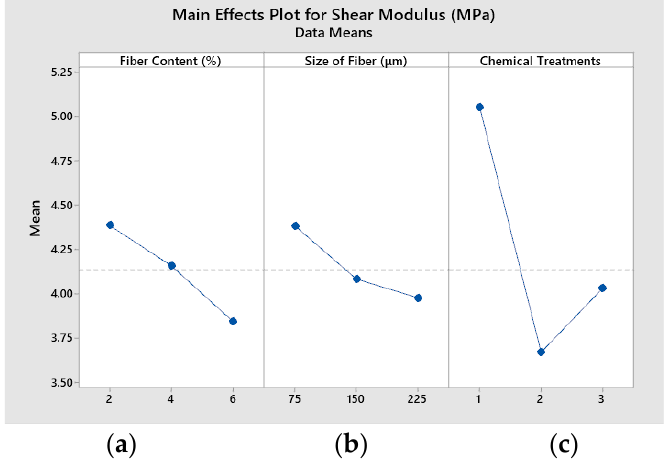
Figure 12. Main effects plot for shear modulus. ( a ) fiber content (%) ( b ) size of fiber ( c ) chemical treatments.